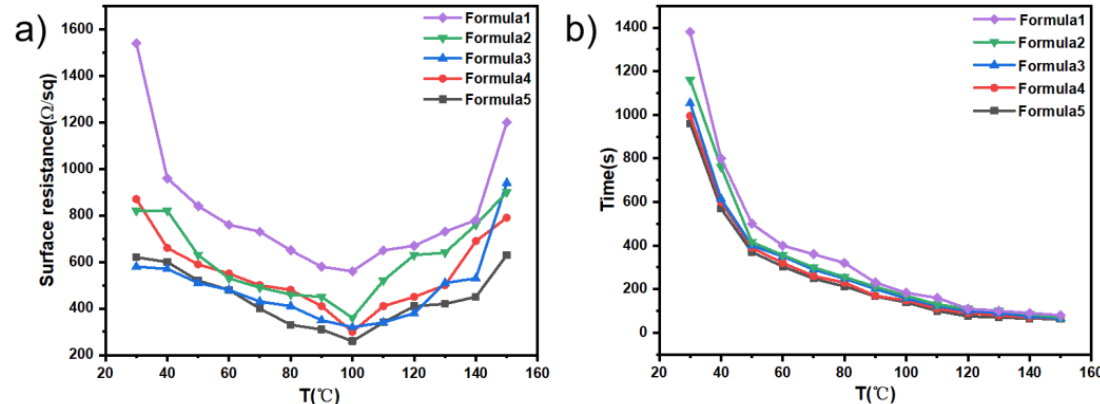
Figure 11. Effect of temperature on deposition of PPy/CNCs on PET substrate ( a ) surface resistance; ( b ) sintering time. Table 2. Conductivity of PPy/CNCs varies with the Py/PVA weight ratio.